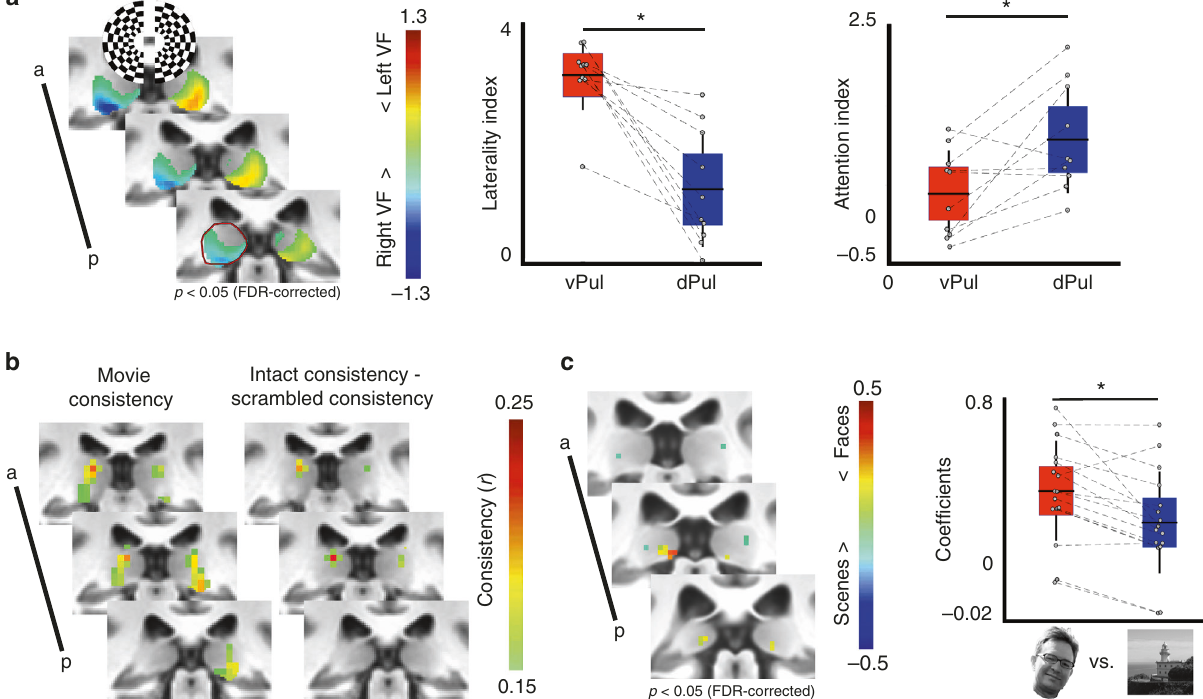
Fig. 1 Functional distinctions within the pulvinar. a The ventral half of the pulvinar showed greater responses to stimulation of contralateral visual space (left, p < 0.05, FDR-corrected, n = 5). Anatomical extent of the left hemisphere pulvinar in posterior-most slice outlined in dark red. Graphs show the group average (horizontal black line), standard deviation (vertical black lines), and 95% con fi dence interval (shaded area) for laterality and attention indices. Grey circles illustrate individual subjects. The ventral pulvinar (vPul) showed greater laterality of responses (middle, t(4) = 5.96, p = 0.004, n = 5), while the dorsal pulvinar (dPul) showed greater attentional modulation (right, t(4) = 3.16, p = 0.034, n = 5). b Repeated presentations of intact movie stimuli evoked consistent responses in both the ventral and dorsal pulvinar. Only the dorsal pulvinar showed greater consistency to repeated presentations of intact vs. temporally-scrambled movies ( r > 0.15, n = 11). c A posterior medial portion of the ventral pulvinar responded preferentially to face vs. scene stimuli in the voxel-wise contrast (left, p < 0.05, FDR corrected, n = 16) and in the ROI analysis (right, z = 3.10, p = 0.002). Graph conventions same as